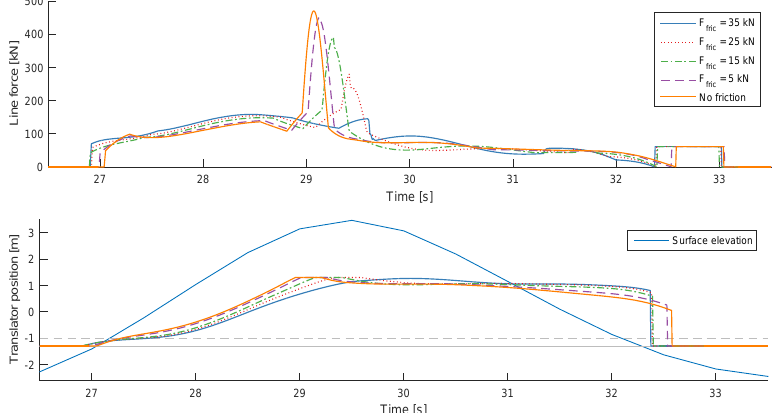
Figure 13. The line force and translator position for different levels of frictional damping. This figure shows the third wave peak of Figure 8. The generator damping factor is constant at γ = 40 kNs/m. The force of the endstop hit is reduced by an increased